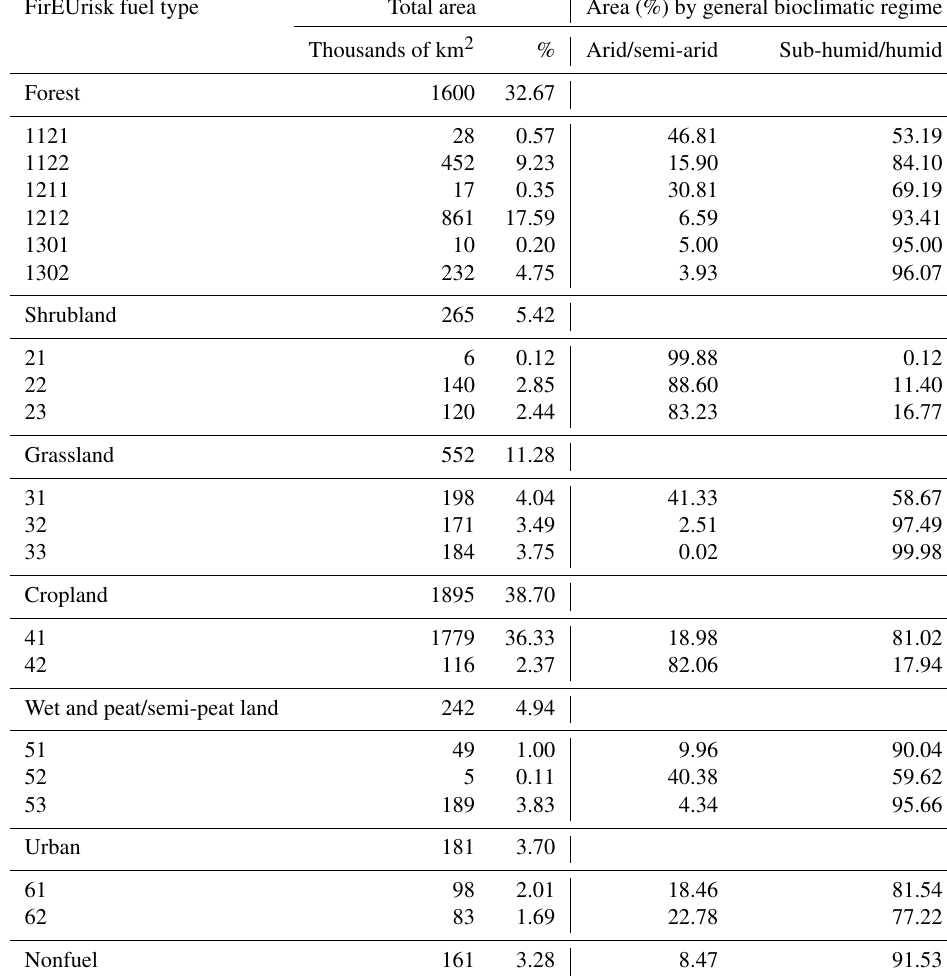
Table B2. Area covered by every mapped FirEUrisk fuel type in Europe (1km spatial resolution). See Table 1 for the fuel type code